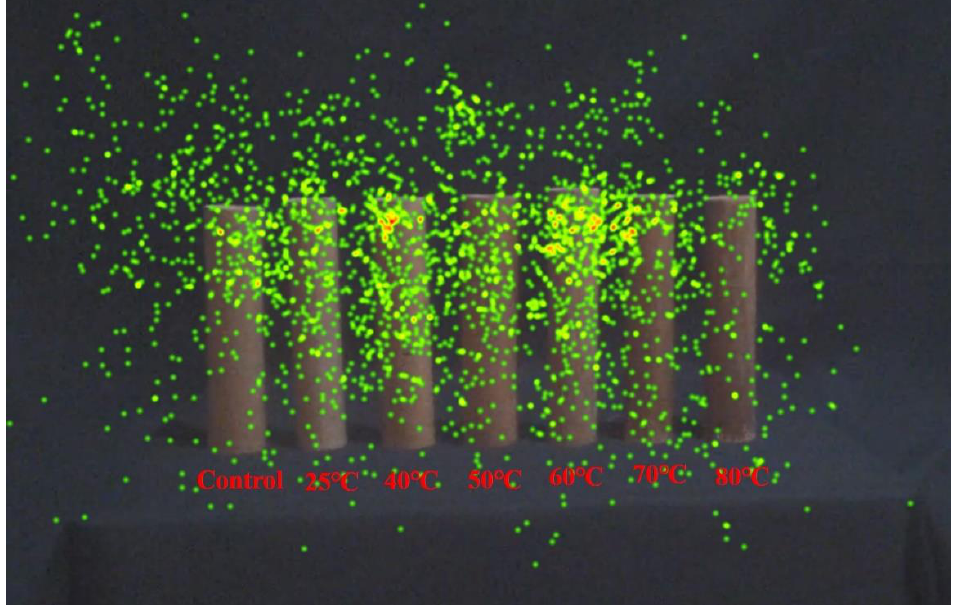
Figure 7. The heat map of bamboo culms in eye tracking test.